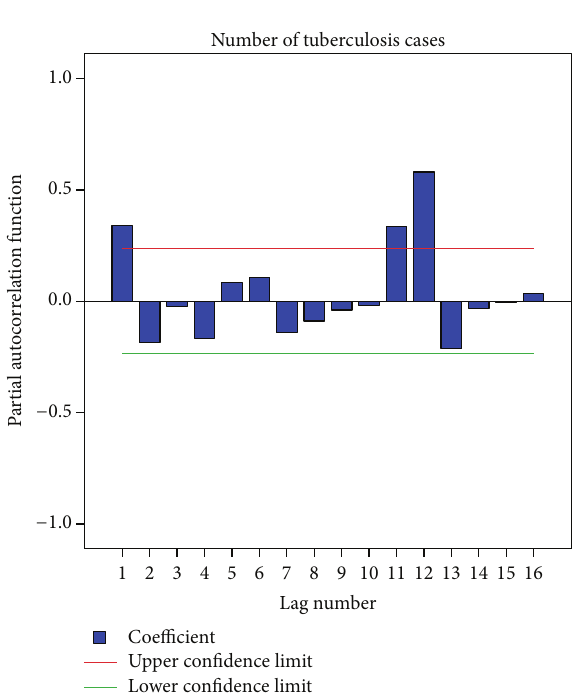
Figure 2: Partial autocorrelation plot for tuberculosis